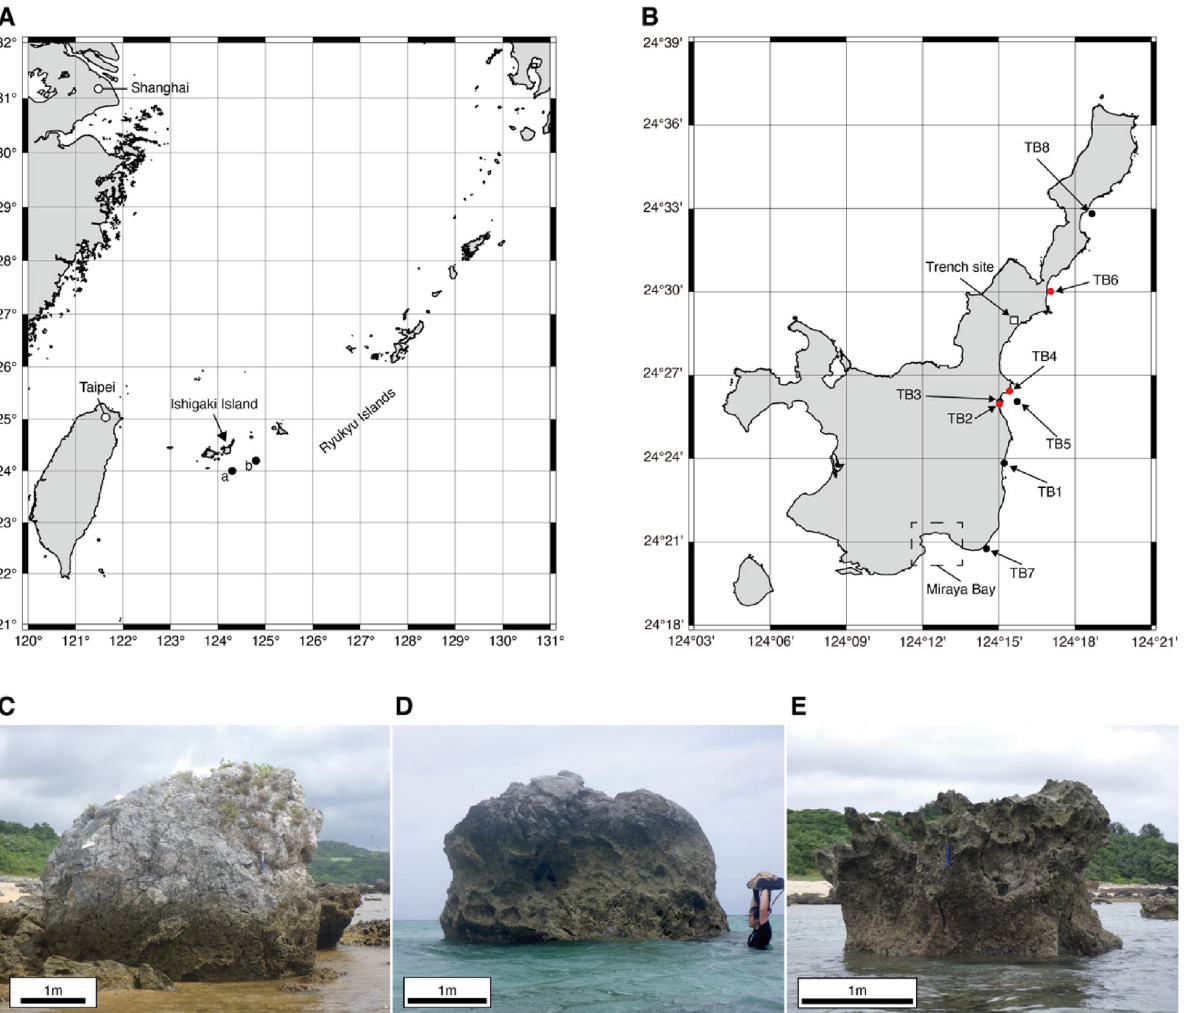
Figure 1. Map of sampling location and sample photos of tsunami boulders. ( A ) Location of Ishigaki Island. Locations a (N24°12, E124°48) and b (N24°, E124°18) denote the epicenters of the earthquake generating the Meiwa tsunami estimated by Imamura 54 and Hatori 55 , respectively. ( B ) Map of Ishigaki Island and the sampling locations (longitude: E124°14.51–E124°18.67 and latitude: N24°20.75–N24°32.82). Red circles represent utilized thermal demagnetization data and black circles indicate boulders that were rejected because the demagnetization data were noisy. The white square is the trench site reported by previous studies 49–51 . The dashed square (Miyara Bay) is the main field of previous VRM dating studies 9,17,24 . The two maps ( A and B ) were generated using the Generic Mapping Tools 6.2.0 (https:// www. gener ic- mappi ng- tools. org/) 52 . ( C ) TB2. ( D ) TB4. ( E )